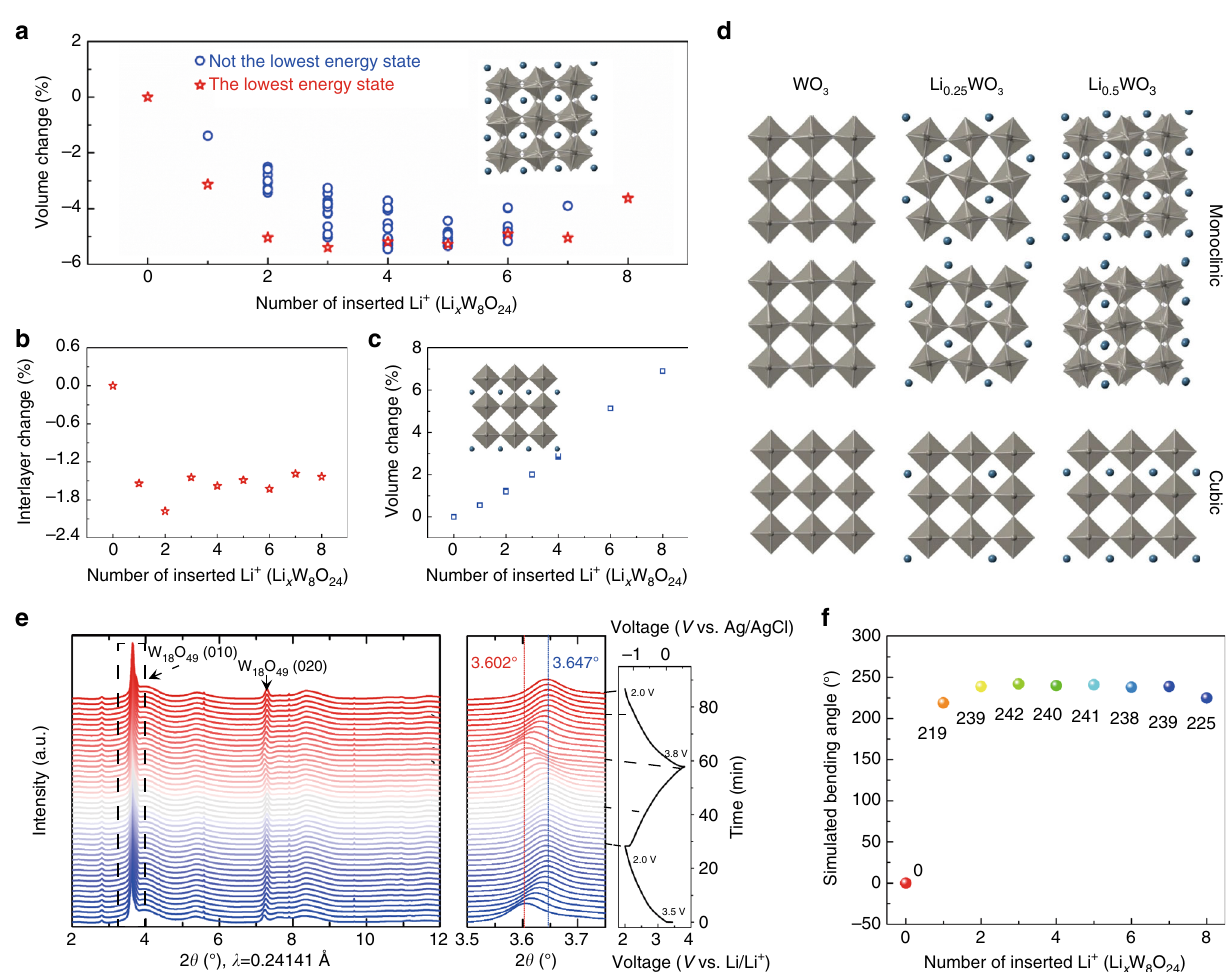
Fig. 3 The veri fi cation for electrochemical actuation of W18O49 nanowires. Volume ( a ) and interlayer ( b ) changes as a function of the number of Li + inserted into monoclinic WO 3 ; c Volume change as a function of the number of Li + inserted into cubic WO 3 . d The corresponding structural evolution during the Li + intercalation process; e In situ synchrotron X-ray diffraction of W 18 O 49 NWs during lithiation/delithiation processes. f Simulated bending angles versus the number of inserted Li